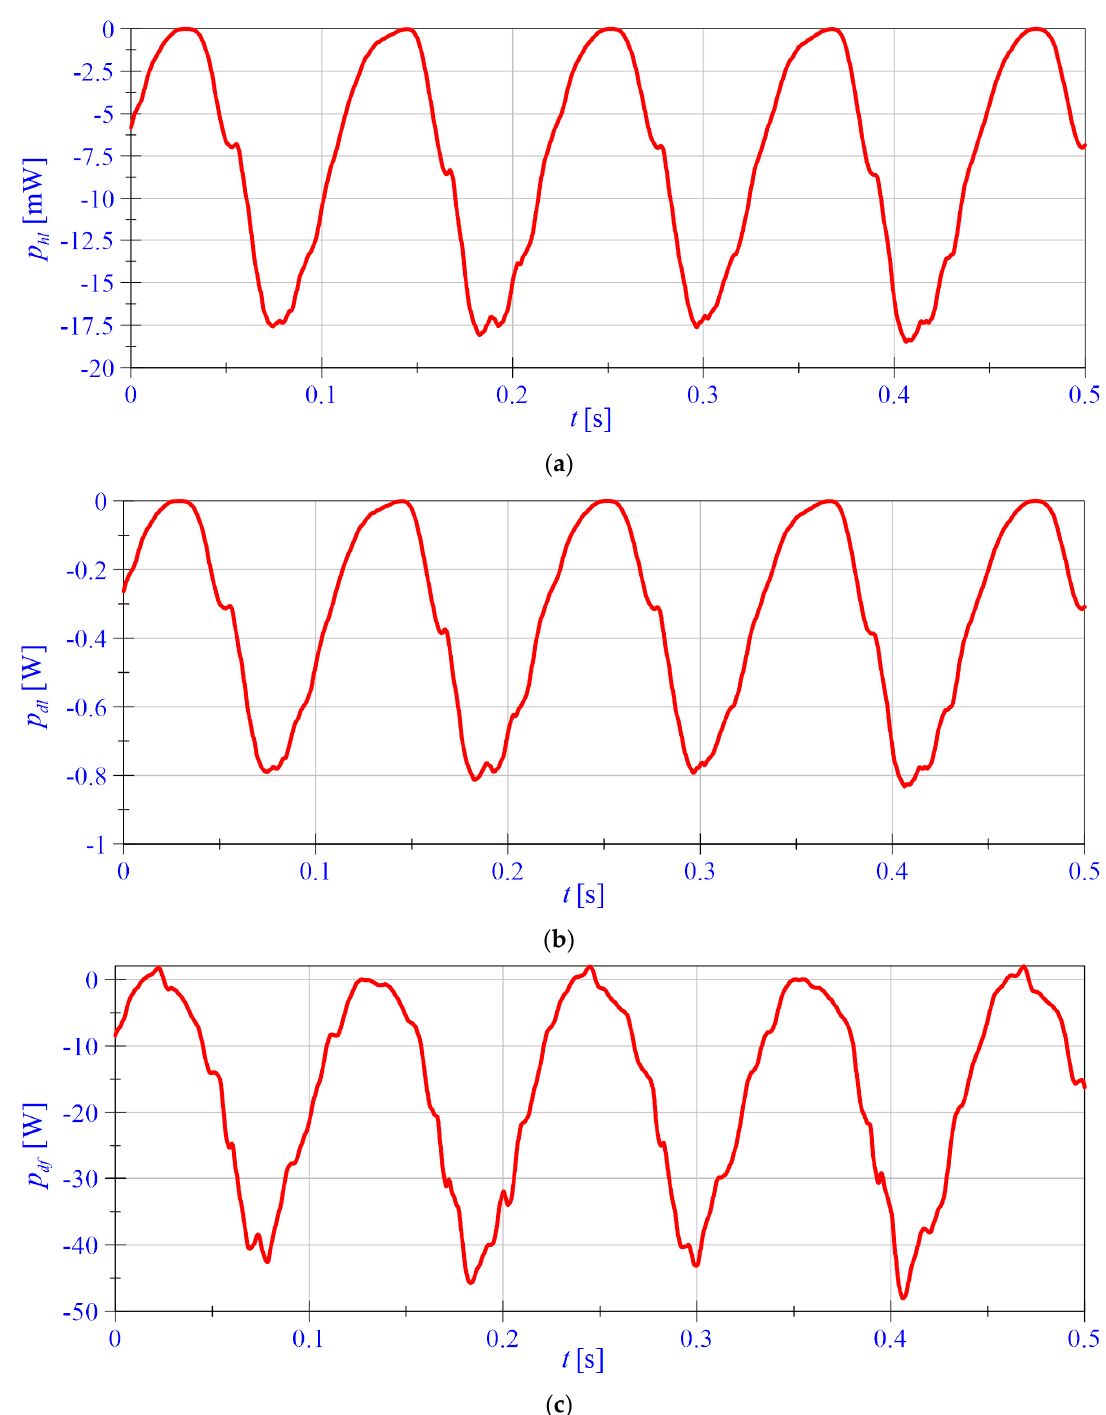
Figure 10. Time histories of power: ( a ) p hl ; ( b ) p dl ; ( c ) p df